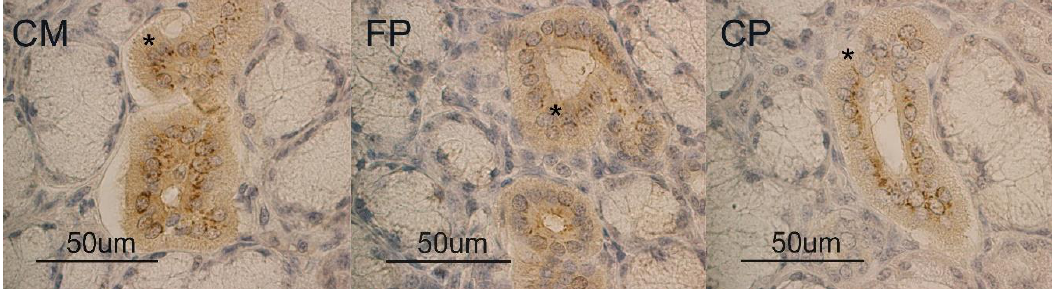
Figure 1. Pig mandibular gland. Apelin (APLN) binding sites at duct (*) level in coarsely ground meal (CM), finely ground pelleted (FP) and coarsely ground pelleted (CP) groups.